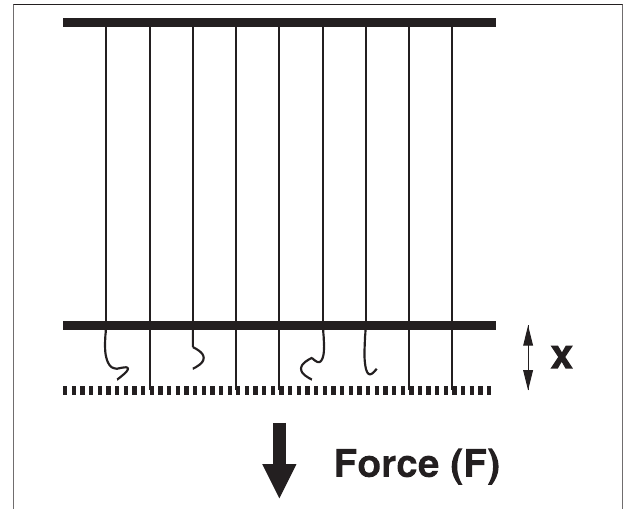
FIGURE 1 | A cartoon ofthe fi ber bundle model where a macroscopically large number ( N ) of Hookean springs, with identical spring constants but different breaking thresholds, hang parallelly from anupper rigidbar and a load/ force F is applied at the lower horizontal rigid bar (not allowing any local deformation ofthe bar and consequent local stress concentration). Ifany spring failsatanytime,the(extra)loadissharedbythesurviving fi bersatthattime.Inthe equal-load-sharingscheme,consideredhere,thisextraloadissharedequallyby all the surviving fi bers ( x denoting the strain of the surviving fi bers).